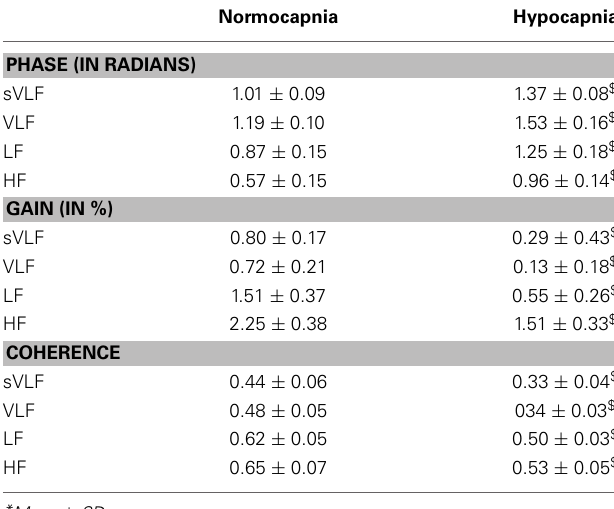
Table 1 | Comparison of phase, gain, and coherence in different frequency bands with respect to normo- and hypocapnia * .